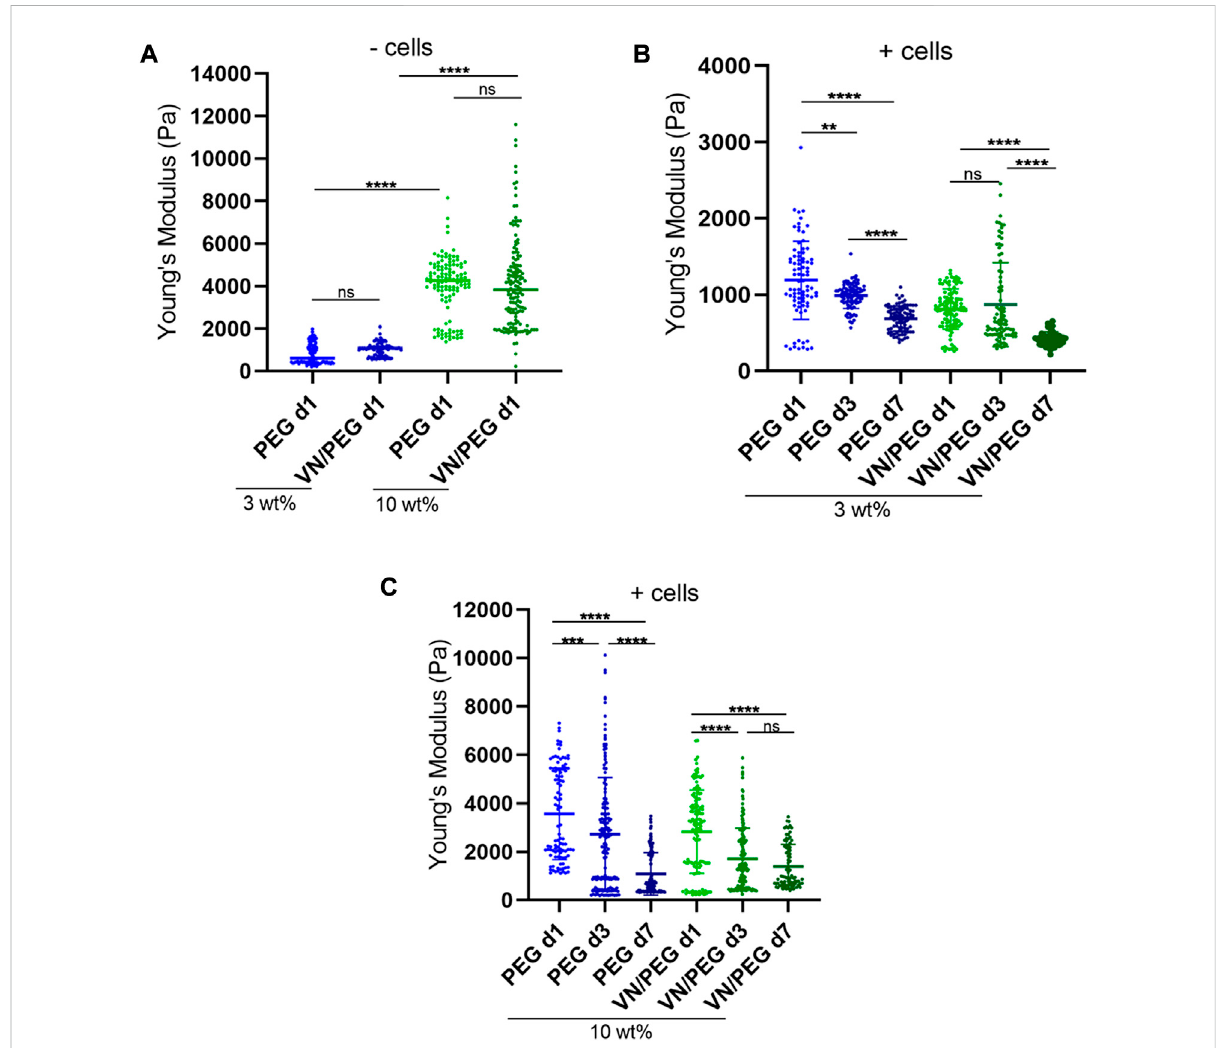
FIGURE 3 3D VN hydrogel with tunable stiffness. (A) . Comparison between 3 and 10 wt% PEG gel stiffness with/without VN measured using nanoindentation. (B,C) . In situ stiffness measurements of 3 (B) and 10 wt% (C) SK-N-BE (2)-loaded hydrogels at 1, 3, and 7 days. A minimum of three maps per replicate were measured and at least two replicates per sample were tested. ANOVA test was used for statistical